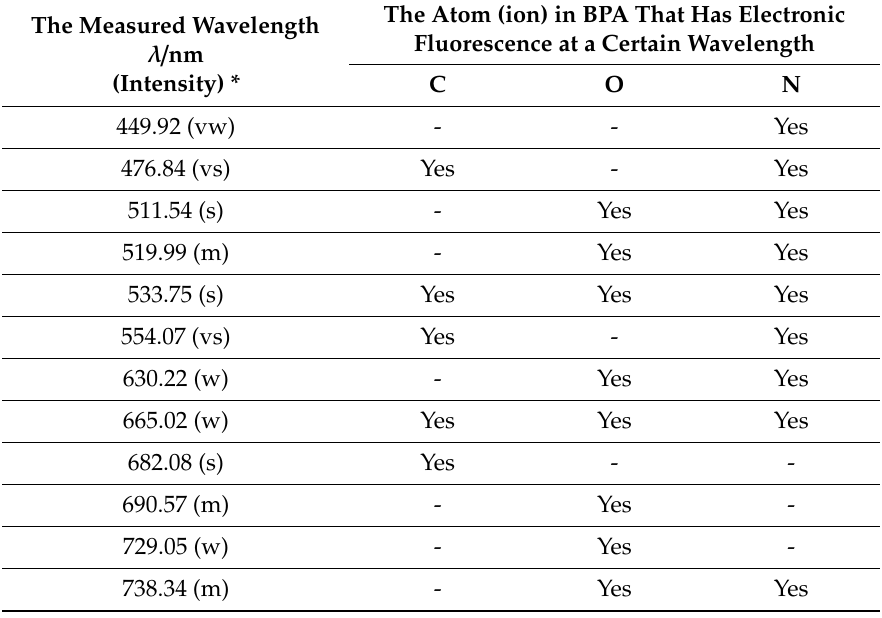
Table 5. Systematization of spectral lines of electronic laser fluorescence of BPA atoms (ions).